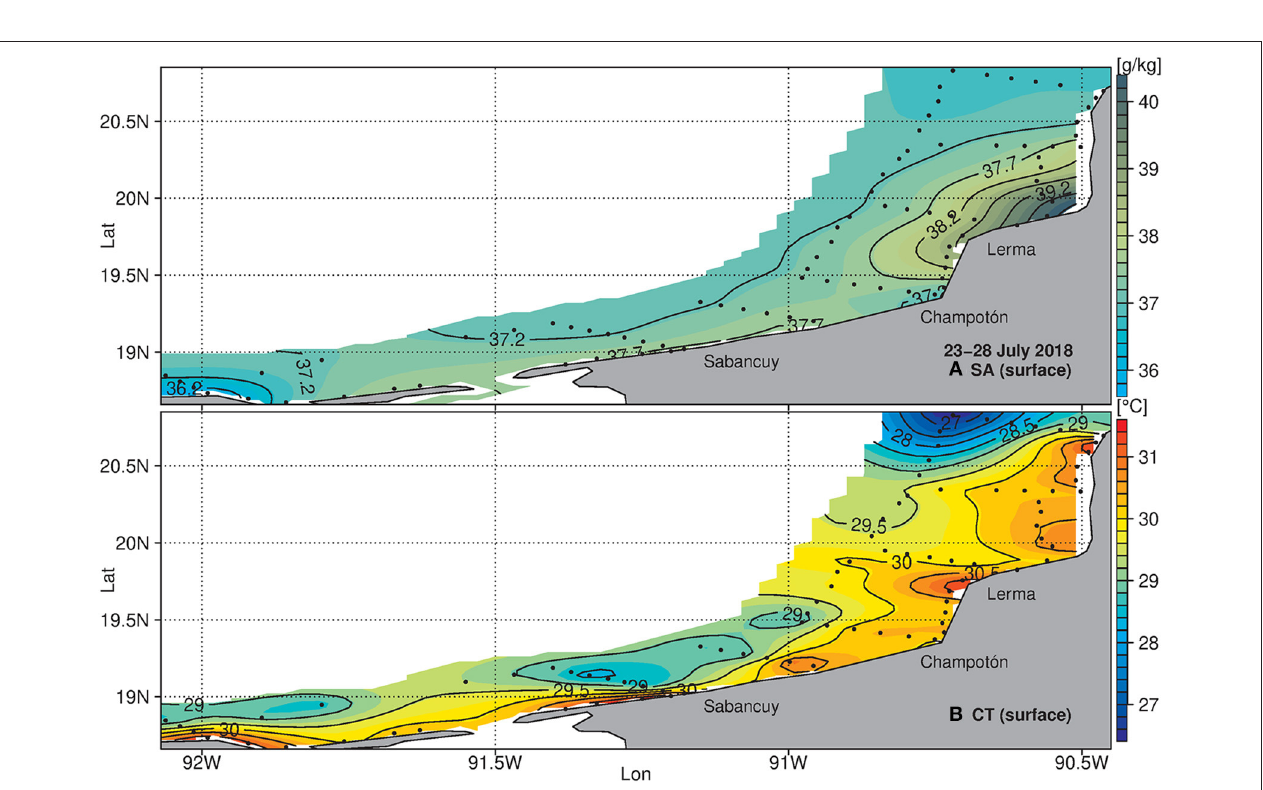
FIGURE 4 | Surface distribution of (A) absolute salinity (g/Kg) and (B) conservative temperature ( ◦ C), optimum-interpolated. This figure synthesizes 6 days of observations, from July 23 to July 28, 2018.